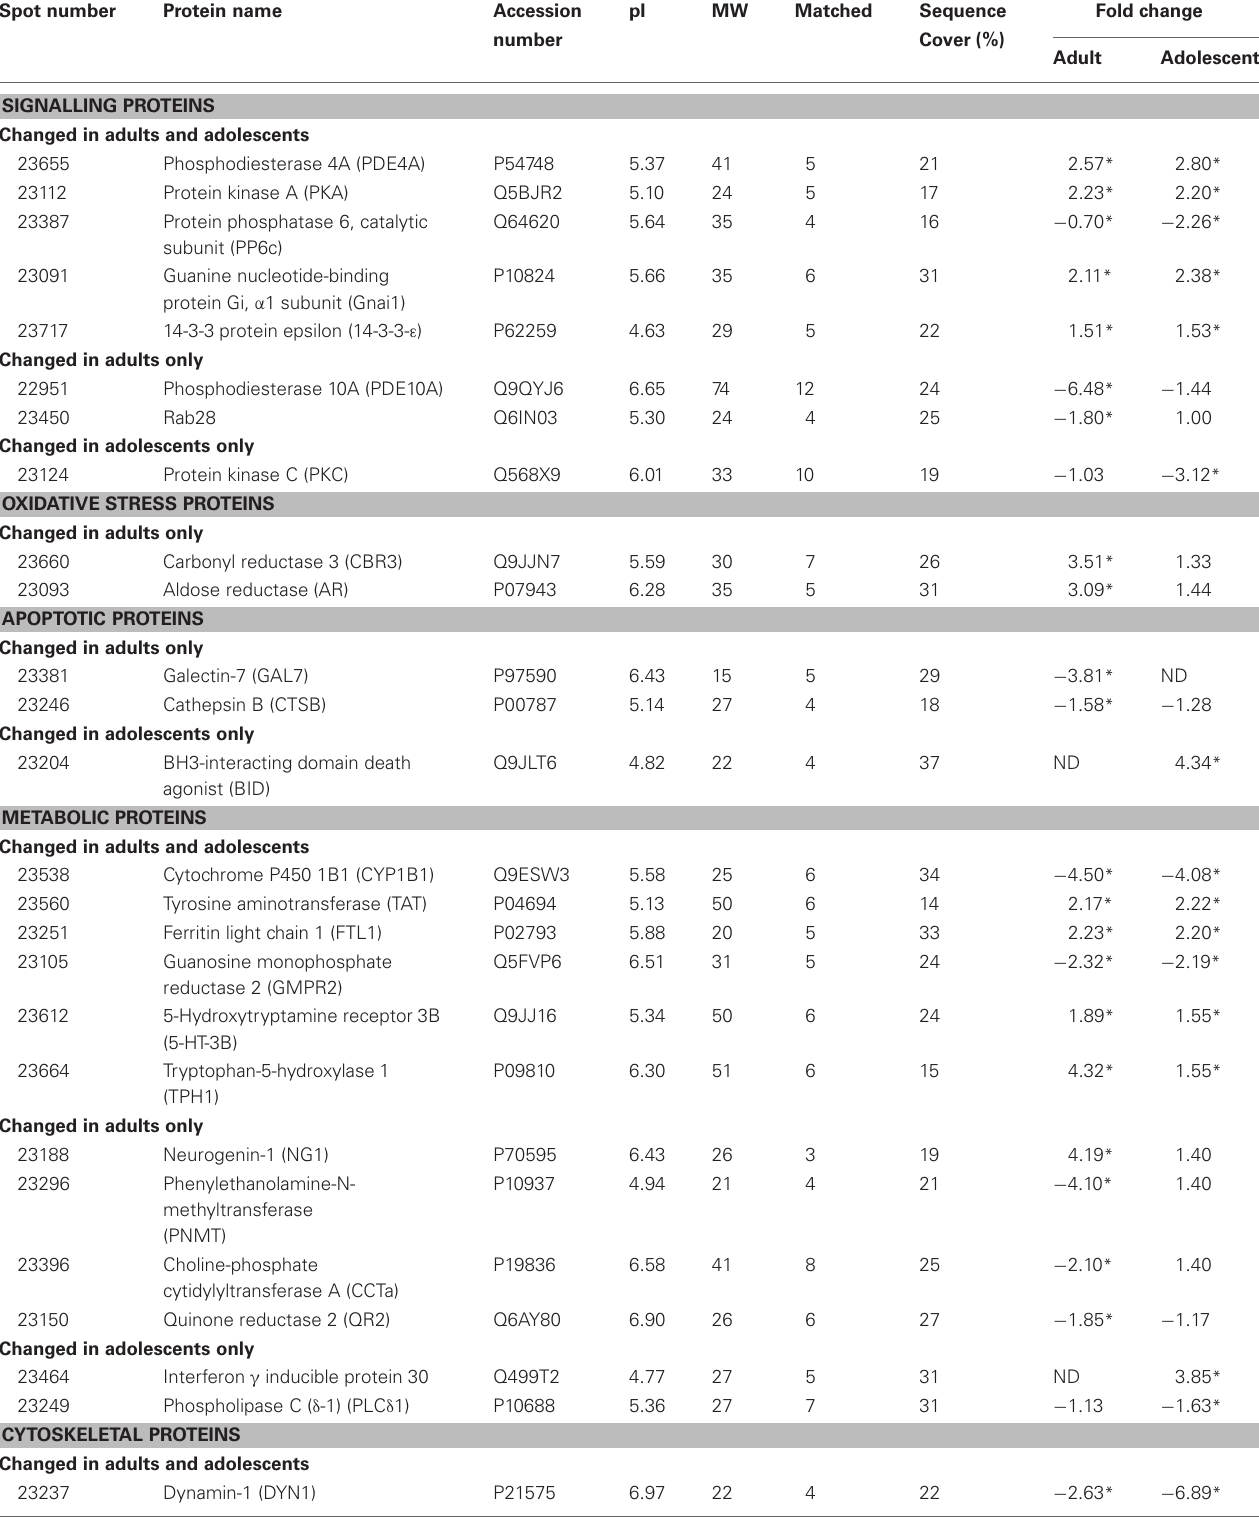
Table 1 | Differentially expressed proteins in the hippocampus of adult and adolescent paroxetine- (PRX) treated rats ( n =